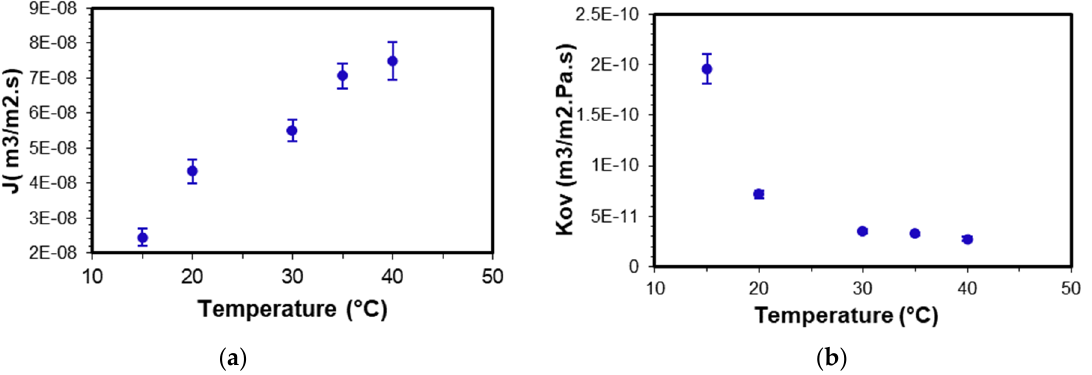
Figure 6. ( a ) Flux for changes in temperature, for 0,8 mol/L of NaHCO 3 . ( b ) K ov for changes in temperature, for 0,8 mol/L of NaHCO 3 .